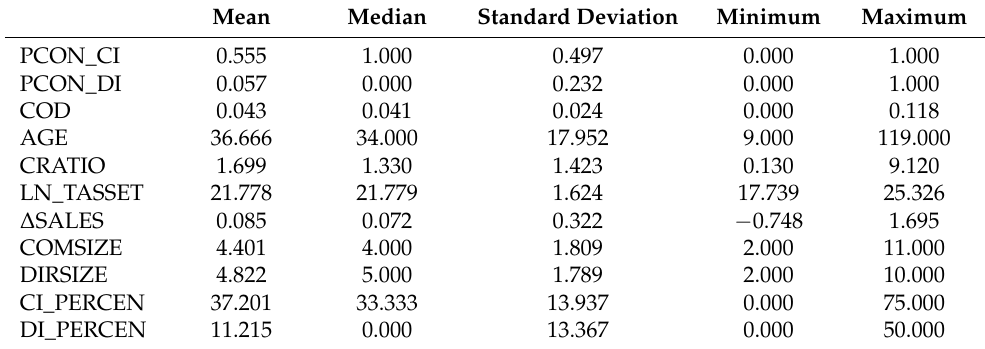
Table 4. Descriptive